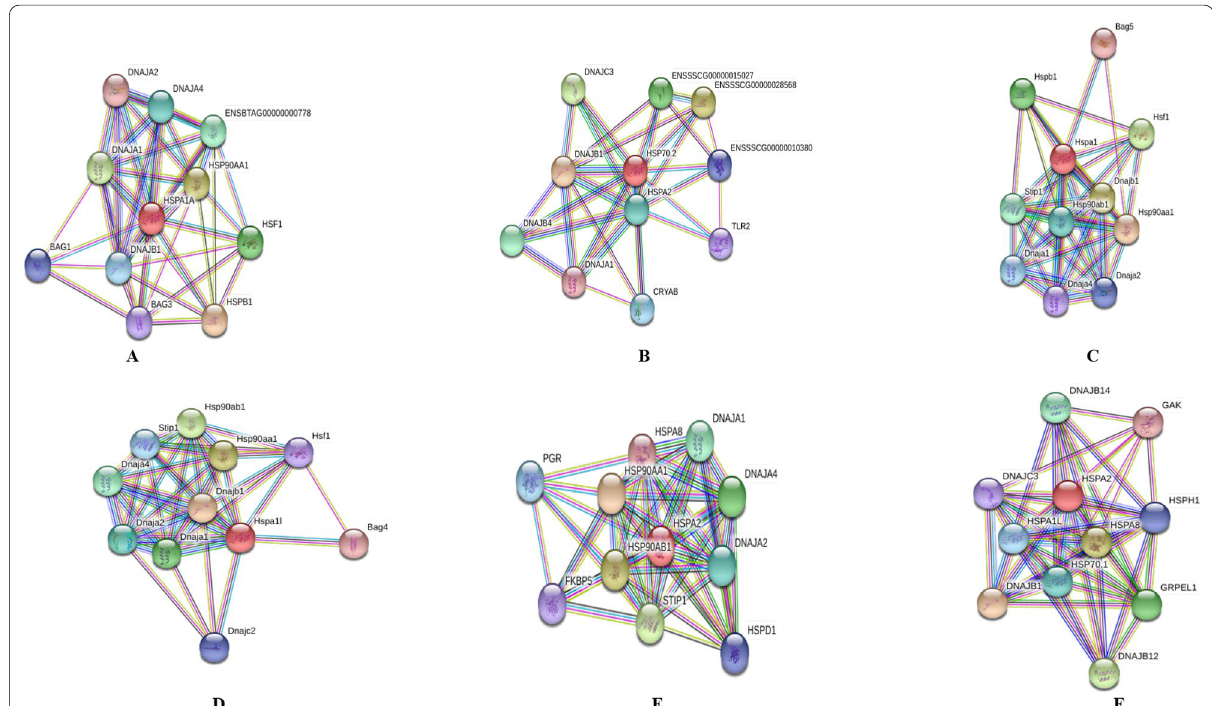
Fig. 3 Protein–protein interaction networks and the functional enrichment analysis of HSP70 in the selected animals. The network nodes are proteins, and the edges represent their predicted functional enrichment associations. The red line indicates the presence of predicted gene fusion evidence; the green line indicates predicted neighbourhood evidence; the blue line represents co-occurrence evidence interactions from known experiment, prediction and data mining sources; the purple line represents association from experimental studies; the yellow line represents association from text mining; the light blue line represents association from database evidence, and the black line represent co-expression evidence. a (A) Cattle, (B) Pig, (C) Rat, (D) Mouse, (E) Chicken, and (F) Goat. b (A) Rabbit, (B) Turkey, (C) Duck, (D) Elegans, (E) Sheep, and (F)